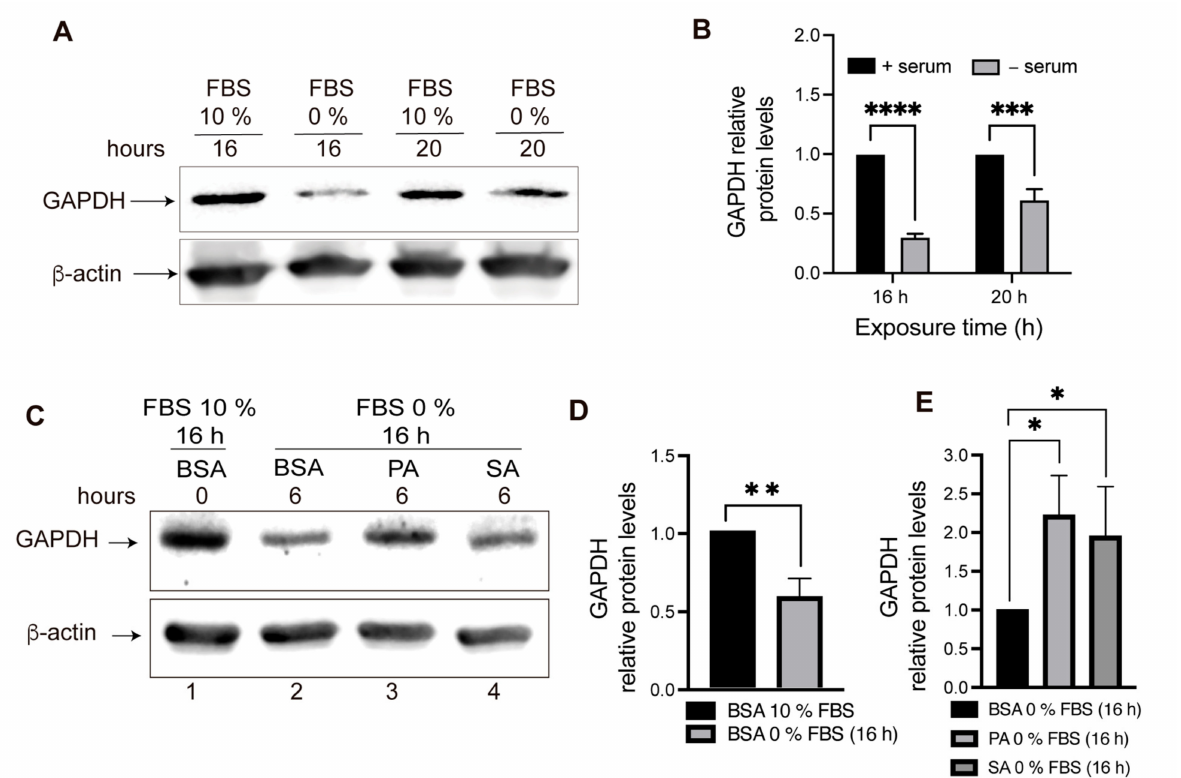
Figure 3. GAPDH protein levels, a well-known CMA substrate, increase in POMC-like neurons treated with PA and SA. ( A ) POMC-like neurons (N43/5) were serum deprived (0% FBS) or not (10% FBS) for 16 or 20 h. Then, total GAPDH protein levels were evaluated by Western blot as an indication of the CMA activity status. β -ACTIN was used a loading control. ( B ) Quantification from Figure 3A using two-way ANOVA ( n = 5). ( C ) POMC-like neurons (N43/5) were incubated with 100 mM of PA, SA, or vehicle (BSA) for 6 h and then serum deprivation (0% FBS) was carried out for 16 h to induce CMA (as a control, cells were incubated for 16 h with 10% FBS). Then, the total GAPDH protein levels were evaluated by Western blot as an indication of the CMA activity status. β -ACTIN was used as a loading control. ( D ) Quantification of lines 1 and 2 from Figure 3C using the Kolmogorov–Smirnov nonparametric t -test ( n = 6). ( E ) Quantification of lines 2, 3, and 4 from Figure 3C using the Kolmogorov–Smirnov nonparametric t -test ( n = 6). n.s. =